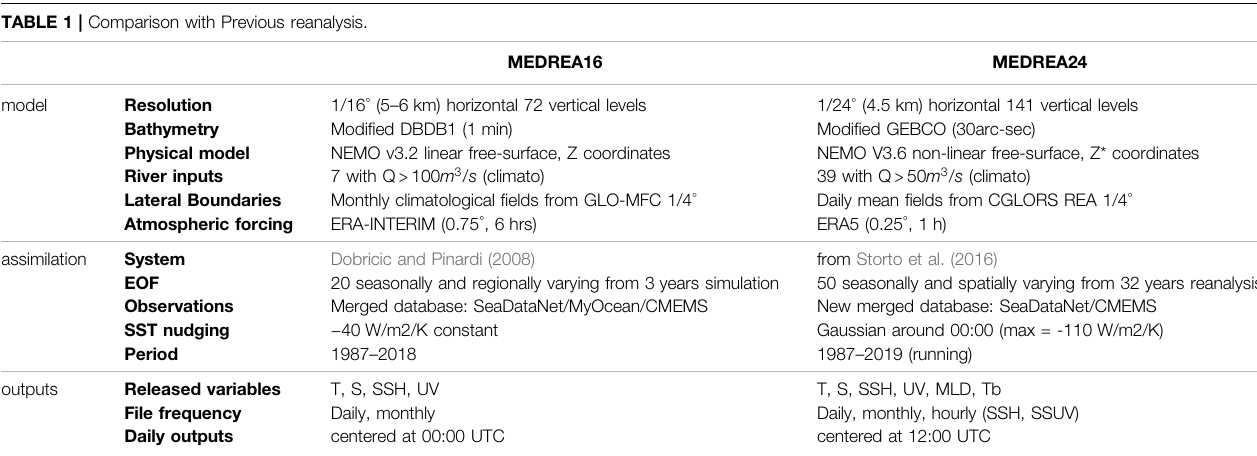
TABLE 1 | Comparison with Previous